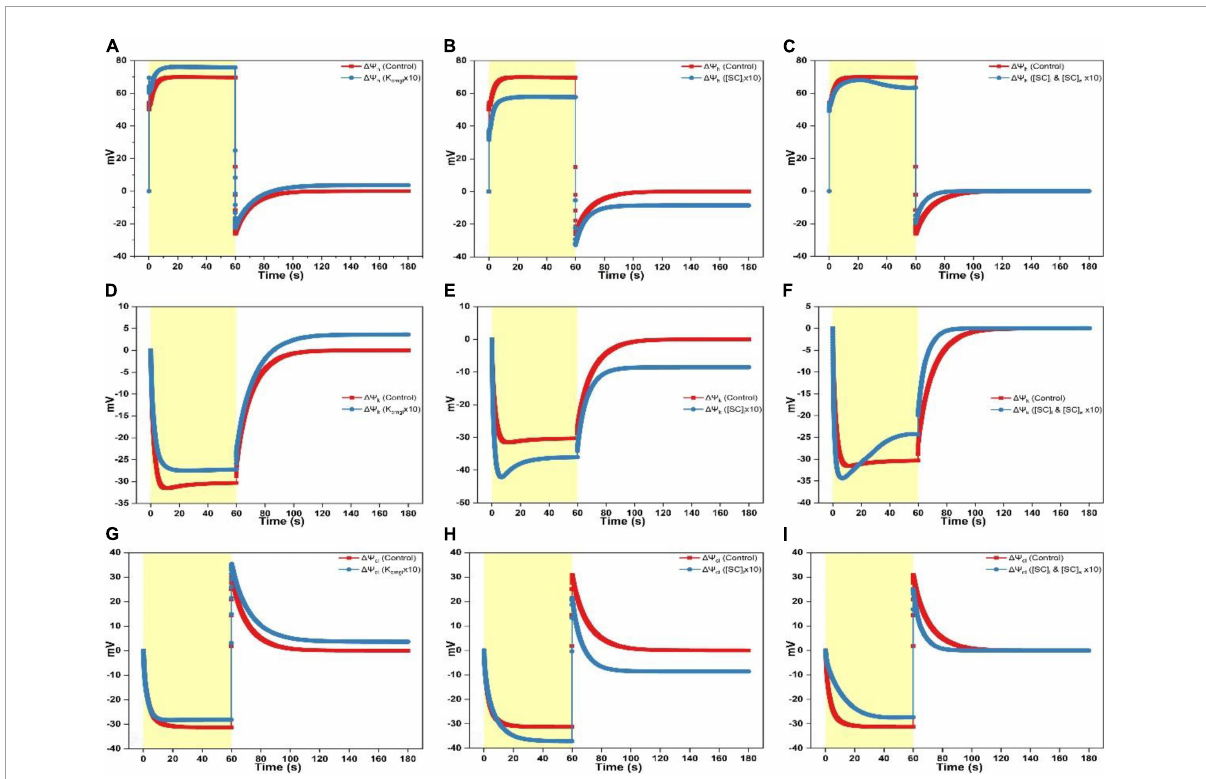
FIGURE2 Simulated responses of (cid:49)(cid:57) h , (cid:49)(cid:57) k , and (cid:49)(cid:57) cl on assigning different values for adjustable parameters. (A) Simulated responses of (cid:49)(cid:57) h by adjusting K cmgl 1- and 10-fold of the controlled value. (B) Simulated responses of (cid:49)(cid:57) h by adjusting [SC] l 1- and 10-fold of the controlled value. (C) Simulated responses of (cid:49)(cid:57) h by adjusting [SC] l and [SC] s 1- and 10-fold of the controlled value. (D) Simulated responses of (cid:49)(cid:57) k by adjusting K cmgl 1- and 10-fold of the controlled value. (E) Simulated responses of (cid:49)(cid:57) k by adjusting [SC] l 1- and 10-fold of the controlled value. (F) Simulated responses of (cid:49)(cid:57) k by adjusting [SC] l and [SC] s 1- and 10-fold of the controlled value. (G) Simulated responses of (cid:49)(cid:57) cl by adjusting K cmgl 1- and 10-fold of the controlled value. (H) Simulated responses of (cid:49)(cid:57) cl by adjusting [SC] l 1- and 10-fold of the controlled value. (I) Simulated responses of (cid:49)(cid:57) cl by adjusting [SC] l and [SC] s 1- and 10-fold of the controlled